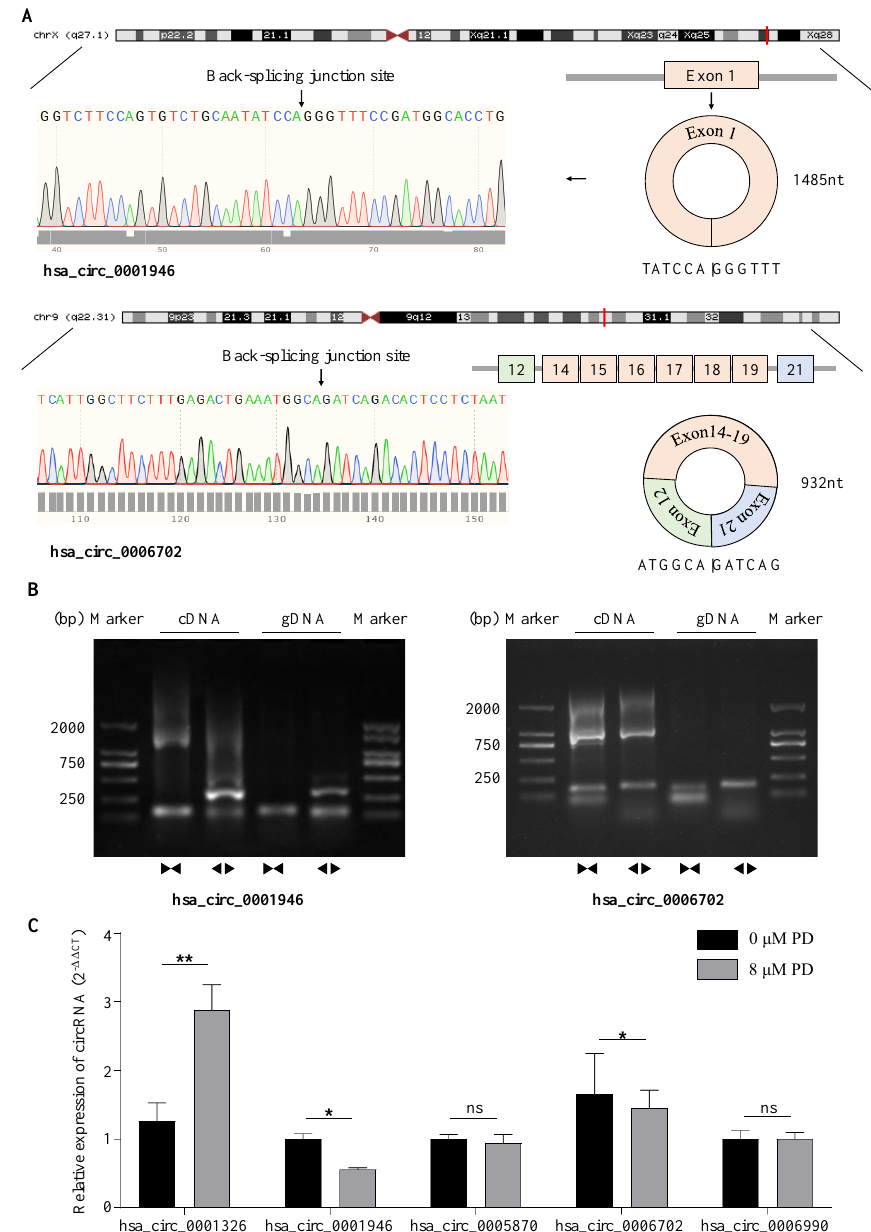
Figure 3. Characterization of DE-circRNAs. ( A ) Genomic location and splicing pattern of hsa_circ_0001946 and hsa_circ_0006702. The back-splicing site was verified by Sanger sequencing. ( B ) Identification of hsa_circ_0001946 and hsa_circ_0006702 qPCR amplification products. DNA gel electrophoresis shows divergent primers amplify hsa_circ_0001946 and hsa_circ_0006702 in cDNA but not in gDNA, convergent primers amplify both linear hsa_circ_0001946 and hsa_circ_0006702. ( C ) The relative expression of selected 5 circRNAs (hsa_circ_0001326, hsa_circ_0001946, hsa_circ_0005870, hsa_circ_0006702, and hsa_circ_0006990) in A549 cells treated with 8 µ M PD for 48 h is determined by qRT-PCR. B-actin and GAPDH were used as internal control. * p < 0.05; ** p < 0.01; ns stands for not statistically